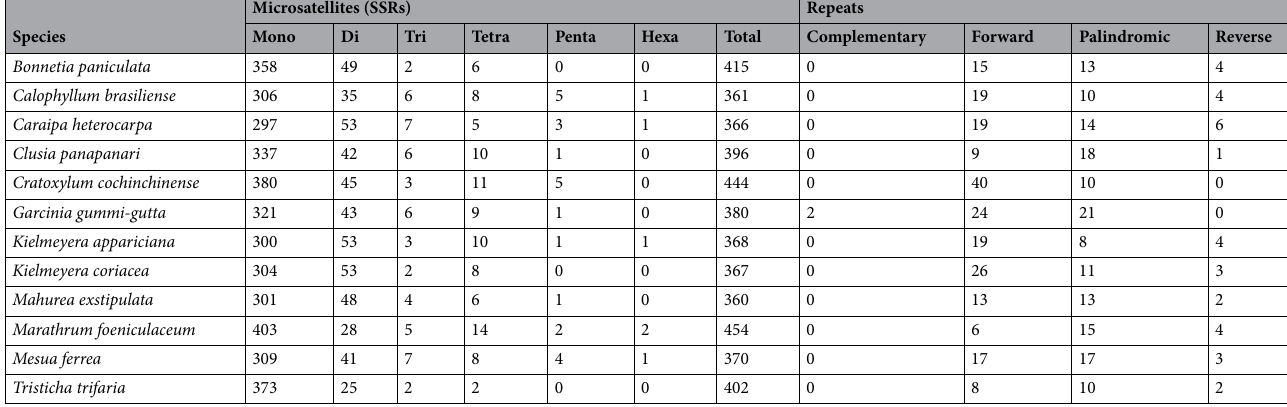
Table 3. Comparison of the number of simple sequence repeats (SSRs) and of long repeats present in 12 clusioid